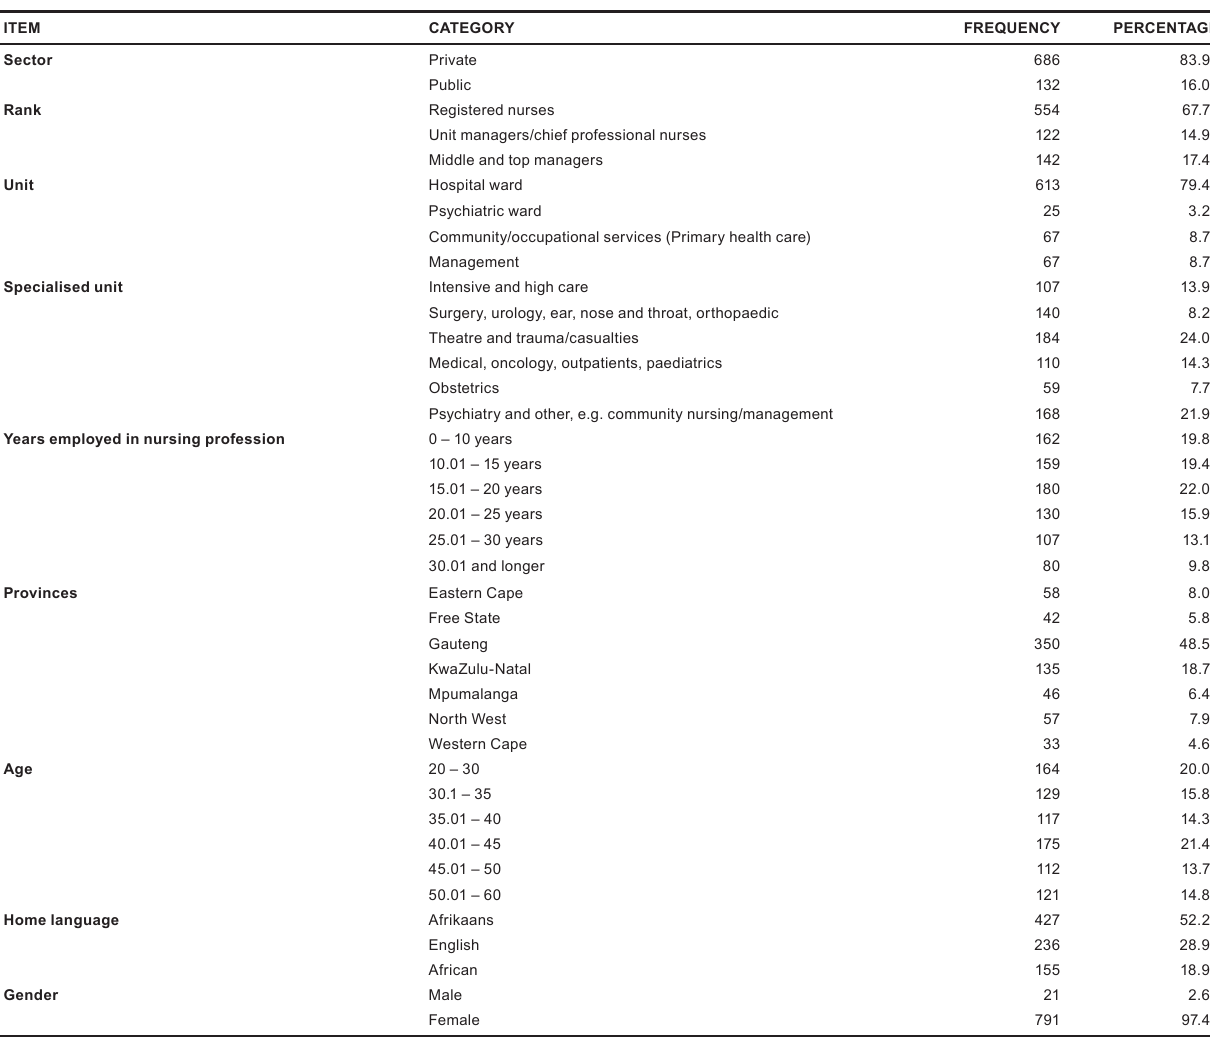
TABLE 1 Characteristics of registered nurses in the